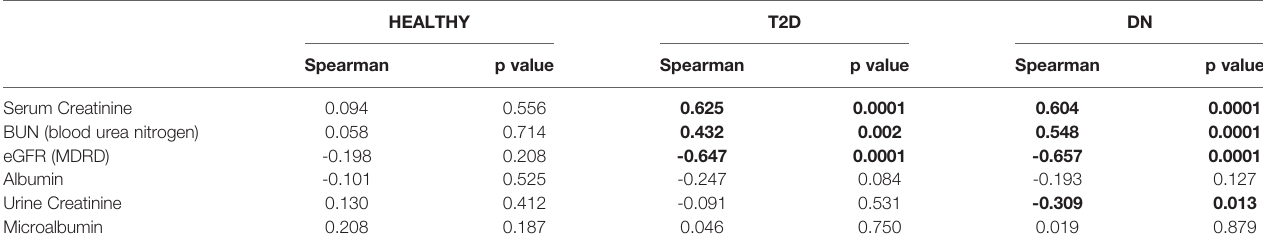
TABLE 3 | Spearman ’ s rank correlation coef fi cient between N-cadherin and renal markers.